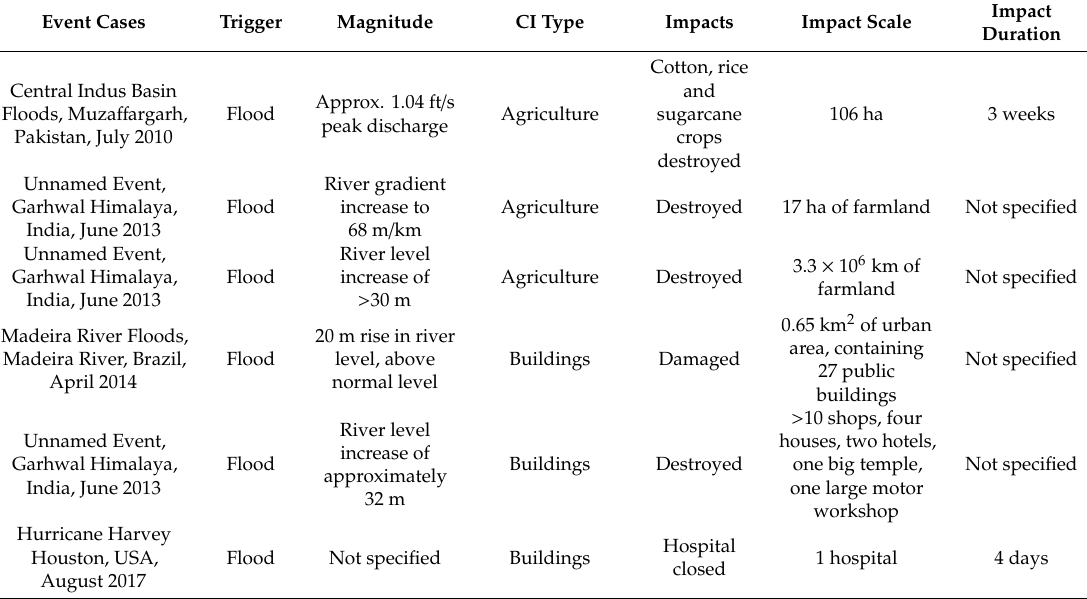
Table A1. Review criteria applied to the current